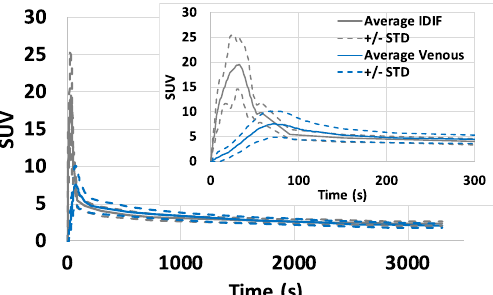
Fig. 9 The average IDIF over 10